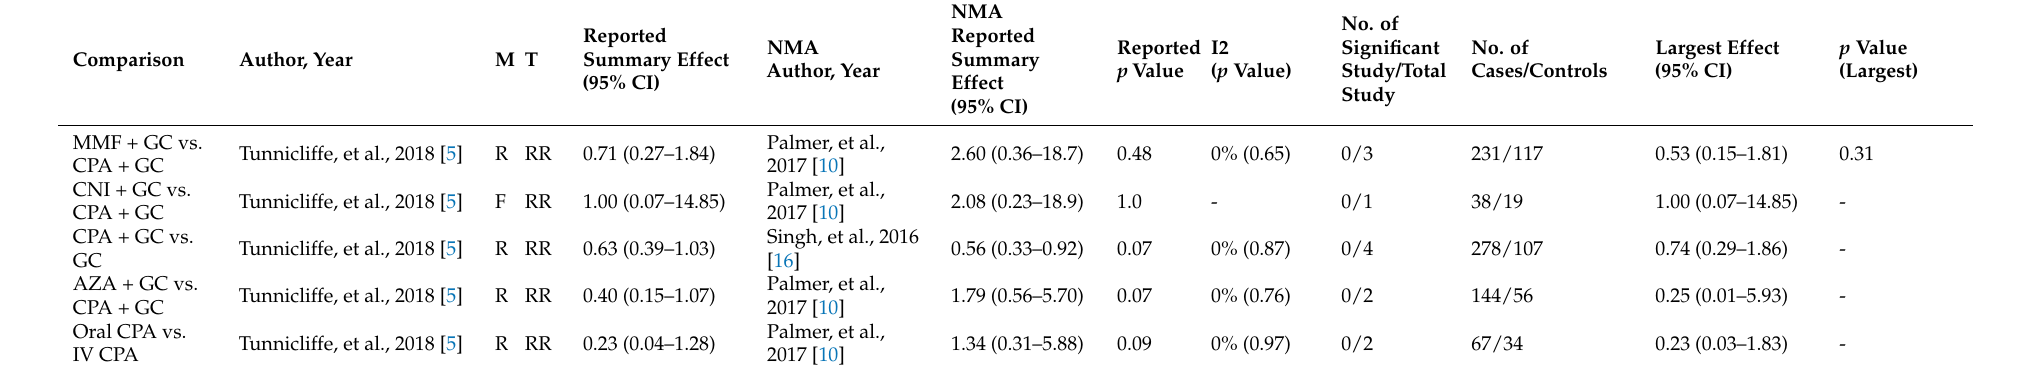
Table 8. Progression to ESRD (compared with Network meta-analysis).